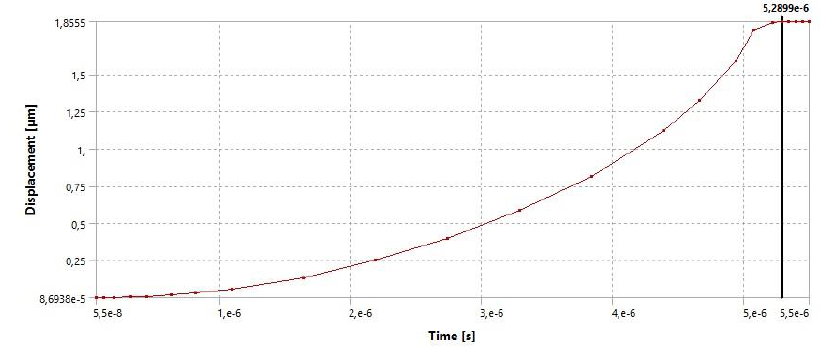
Fig. 6. Deformation of the MEMS switch membrane when an electrostatic field is applied. shown. In this case, the time of switching the membrane to the down position is 5.29 µs with the magnitude of the pull-down voltage of 15 V.